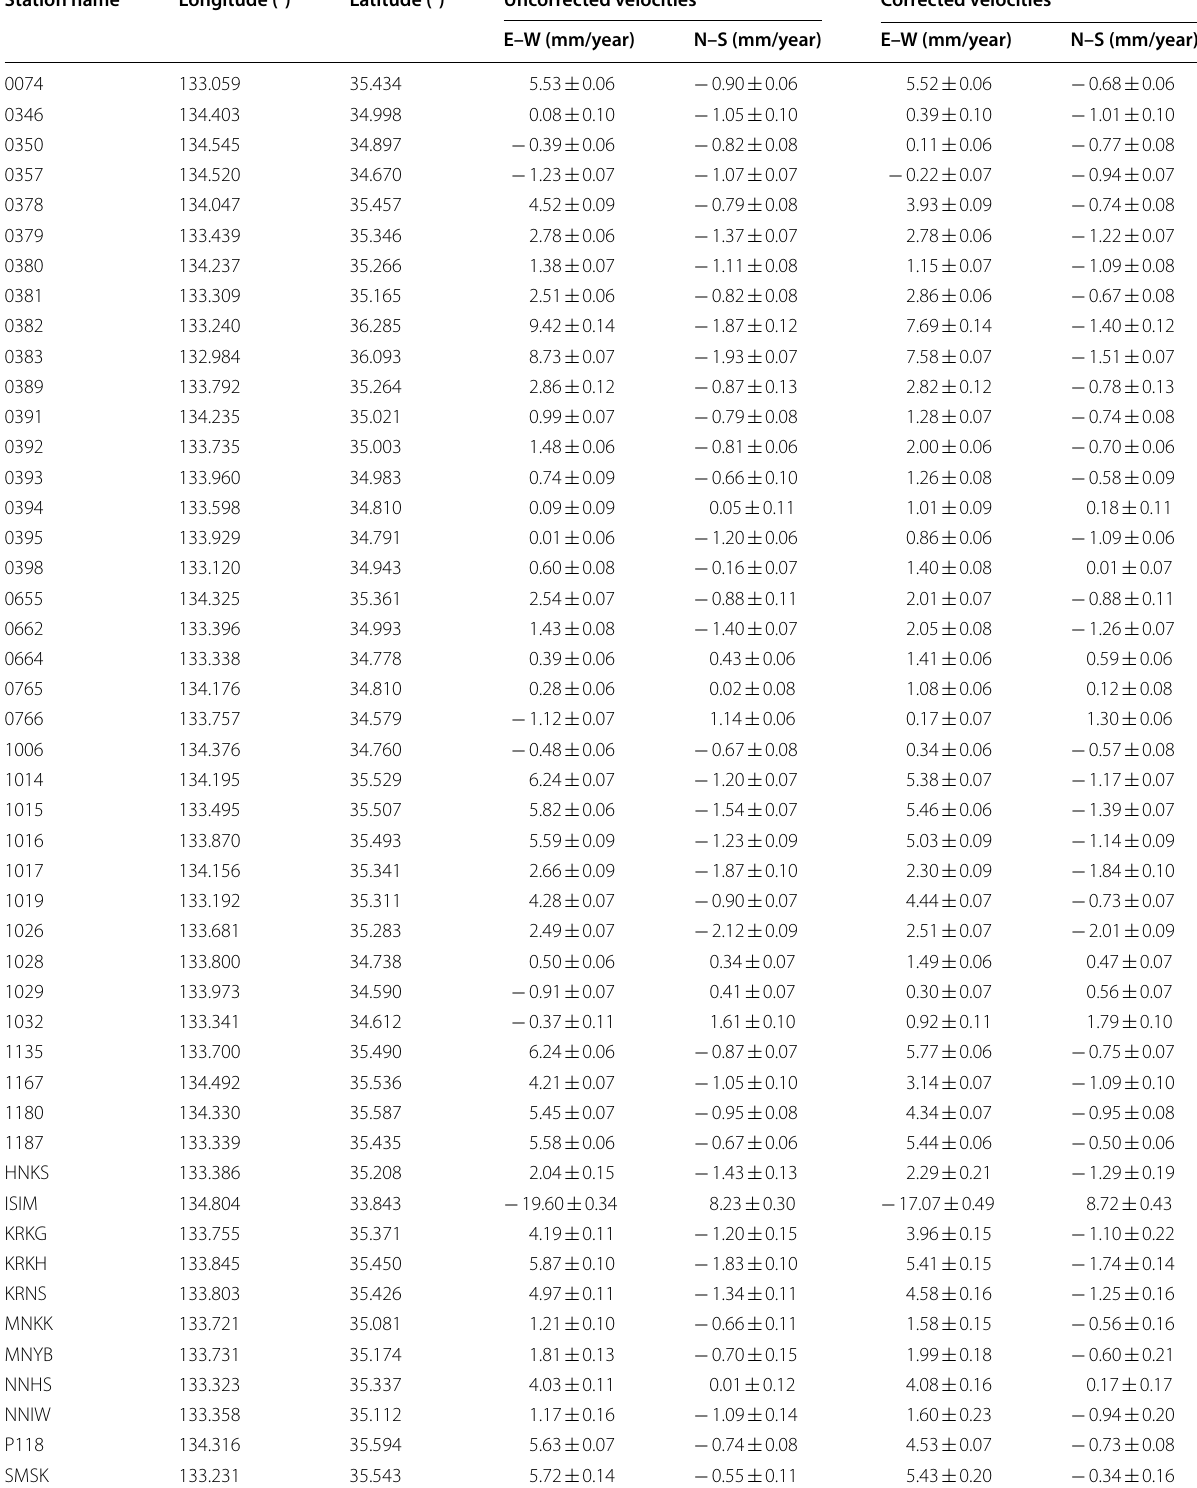
Table 1 Coordinates and observed horizontal displacement rates of GNSS stations used for modeling before and after removing the effect of the 2011 Tohoku-oki